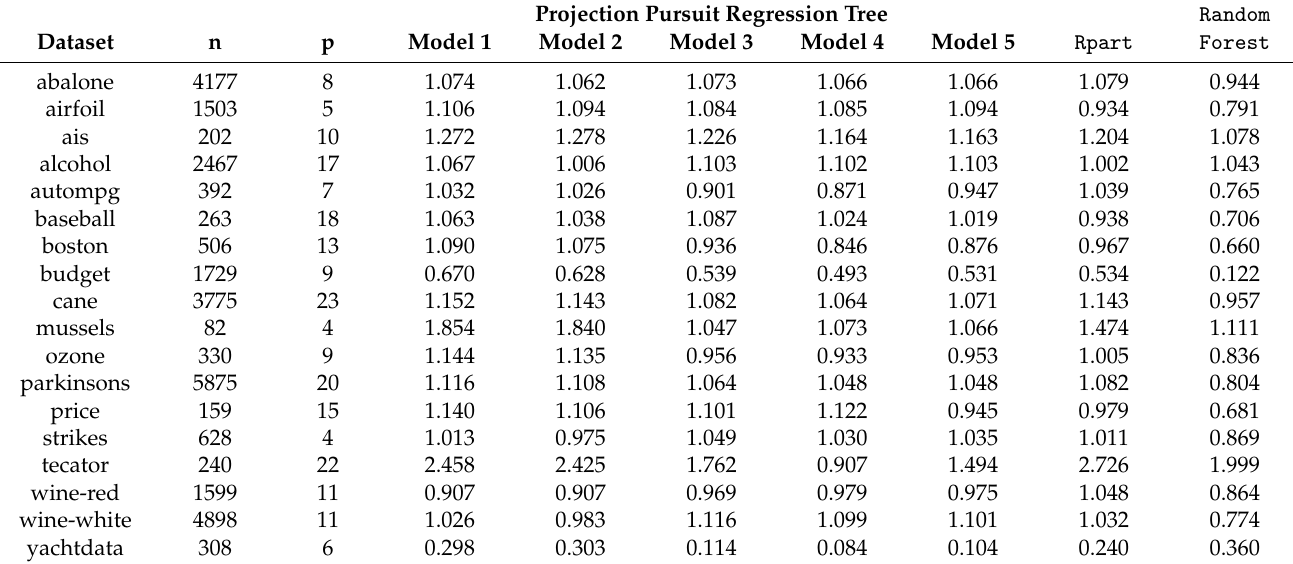
Table 10. Comparison of lm , rpart , randomForest , and the projection pursuit regression tree with various data sets; the mean MAE/MAE( lm )of 200 iterations for the test